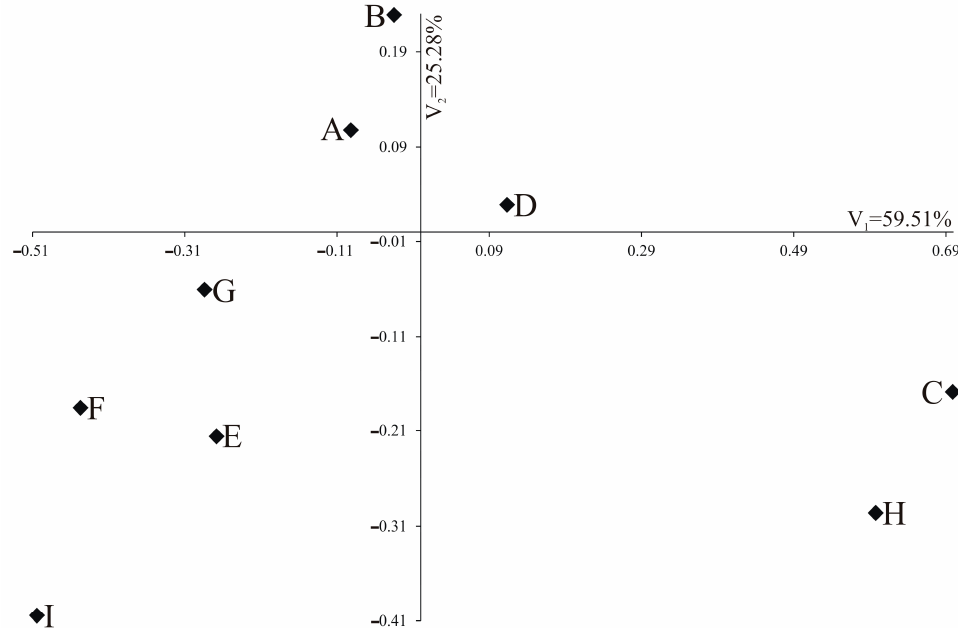
Figure 5. Distribution of nine habitats in the space of the first two canonical variables (V 1 and V 2 ), A–I abbreviated habitat names (see: Table 1). The greatest variation in terms of all the fi ve traits jointly measured with Mahalanobis distances was found for habitats C and F (distance between them amounted to 1.2447). The greatest similarity was found between habitats A and B (0.2511). In the dendrogram presented in Figure 6, all the examined habitats were divided into two groups as a result of agglomeration grouping using the Euclidean distance method. The fi rst (I) group comprised two habitats: C and H. The second (II) group comprised the other seven habitats. The second group was divided into two subgroups with three (A, B and D) and four habitats (E, F, G and I), respectively.